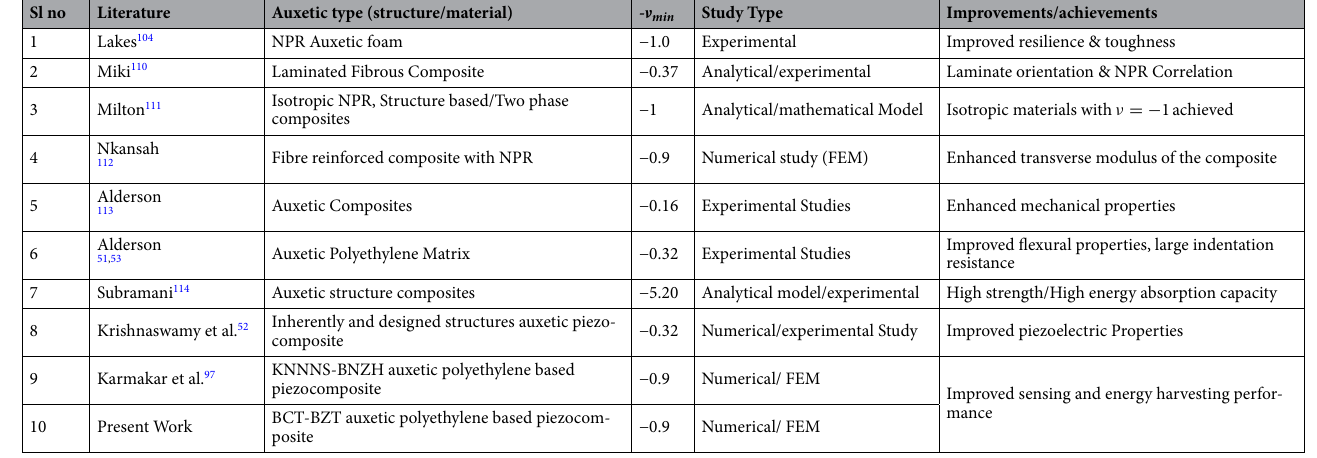
Table 2. Previous work done on Auxetic